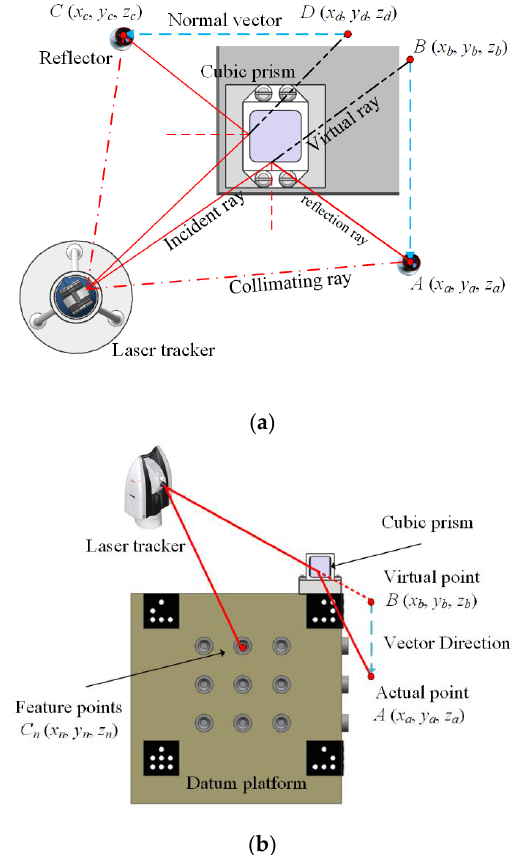
Figure 4. Datum alignment of theodolite and laser tracker: ( a ) principle of cubic prism to create mirror vectors; ( b ) alignment of the cubic prism coordinate system with the datum platform coordinate system.